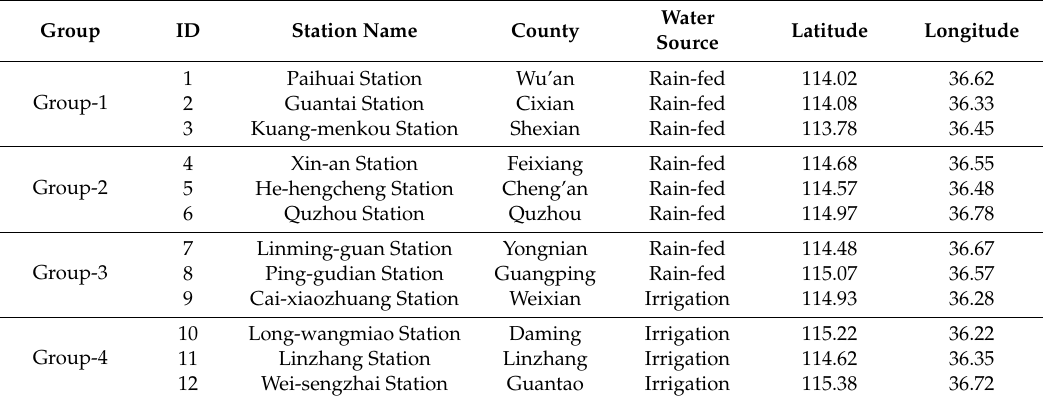
Table 5. Soil moisture monitoring stations in the study area.